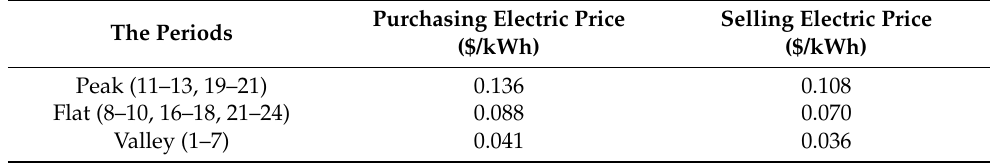
Table 3. Electricity prices in different time